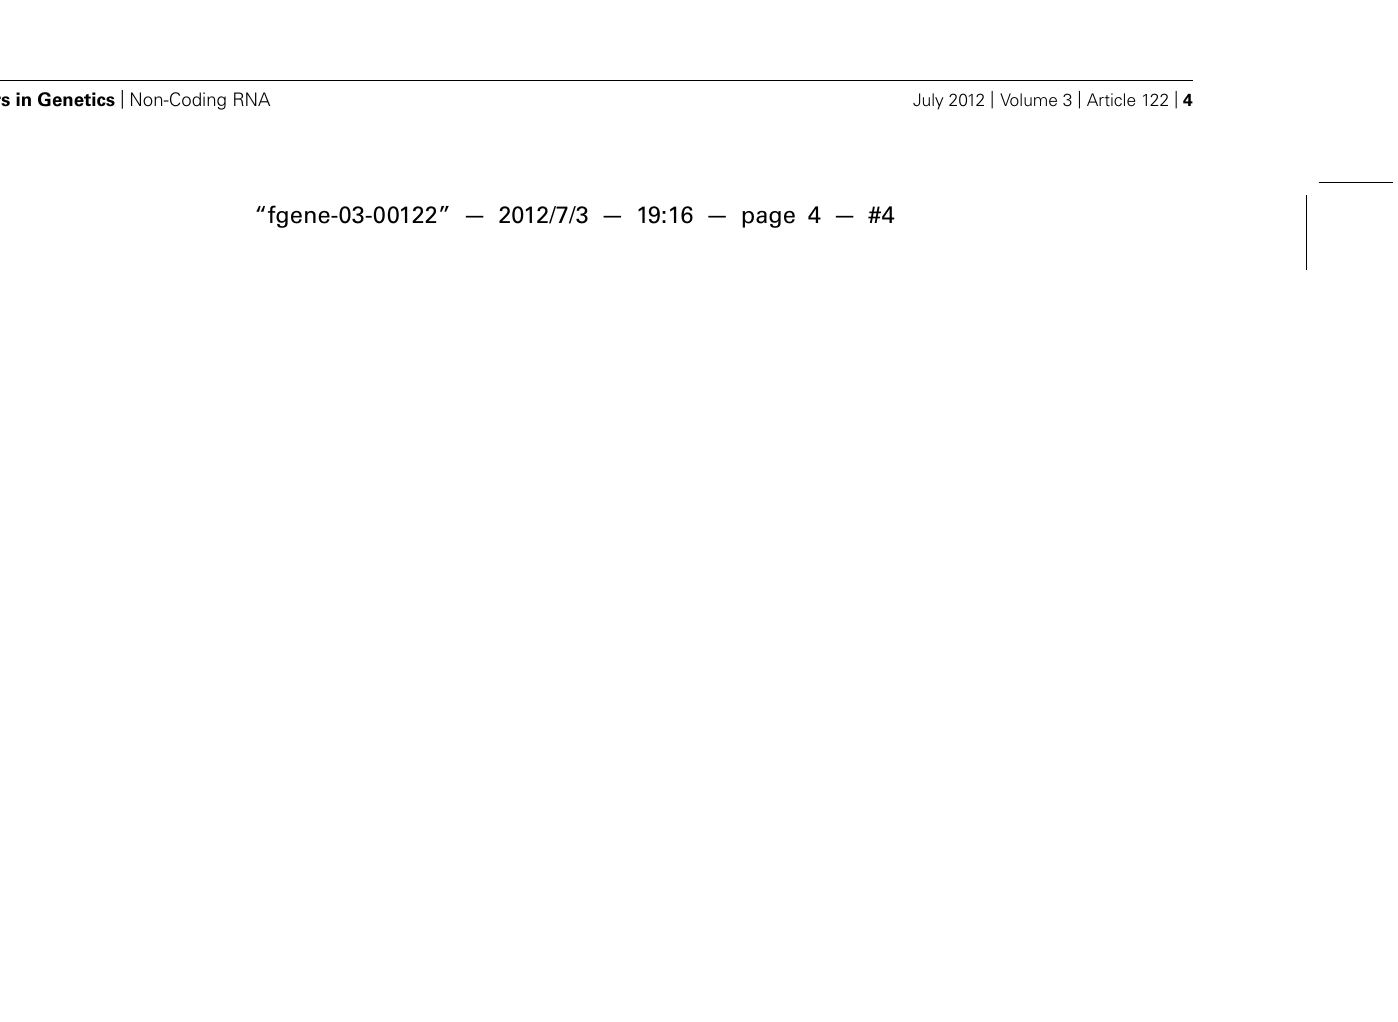
Vertebrates have four sets of Hox clusters generated by two rounds of polyploidization events that occurred prior to the divergence of jawless and jawed